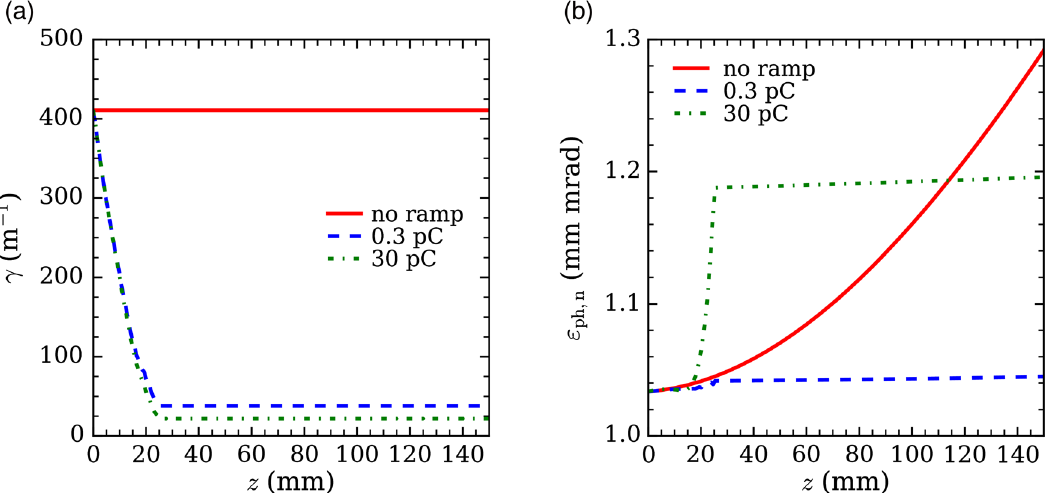
FIG. 6. Evolution of Twiss parameter γ (a) and normalized phase emittance ε drift, for the adiabatic density profiles ( g ¼ 100 m − 1 ), compared to the case without a ramp. The case of a very low particle charge (0.3 pC) is also shown. z ¼ 0 mm is the down ramp